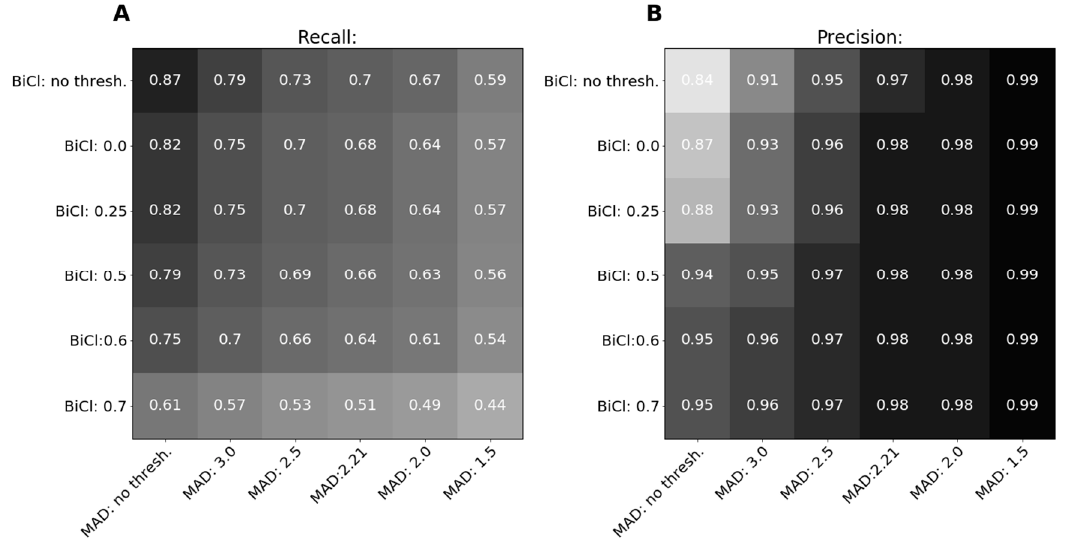
Figure 10. Evaluation of gold standard (EN–GA) for various BiCleaner and MAD thresholds. The first row shows recall/precision when no threshold is set for BiCleaner, the first column shows recall/precision when no threshold is set for MAD. ( A ) Recall. ( B ) Precision.